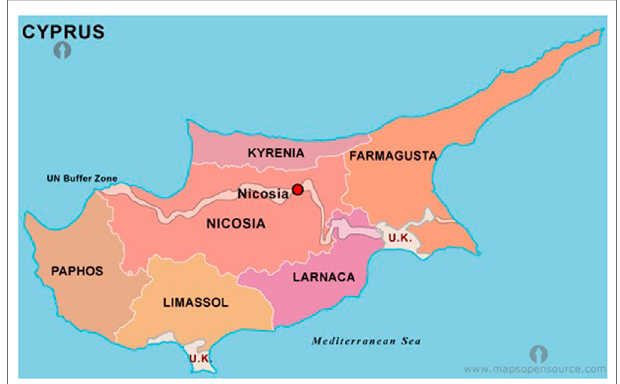
FIGURE 1 | Map of cyprus source: http://mapsopensource.com/ images/cyprus-map.gif.